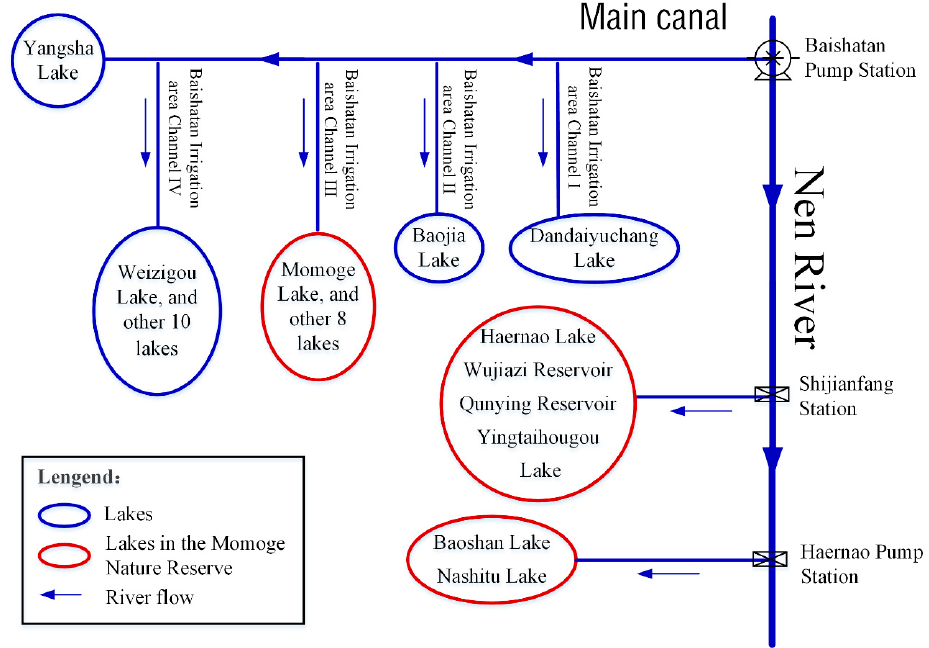
Figure 1. Schematic diagram of Nenjiang water supply node in the Momoge National Nature Reserve (MNNR).